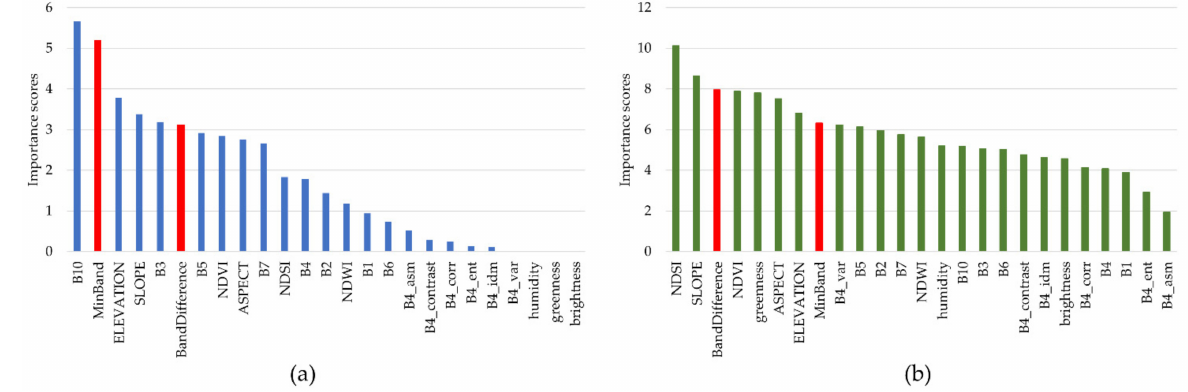
Figure 7. Importance score: ( a ) is the first classification and ( b ) is the second classification.